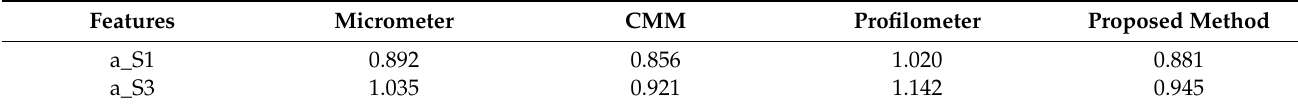
Table 5. Results of comparison with existing methods for cylindricity (mm).